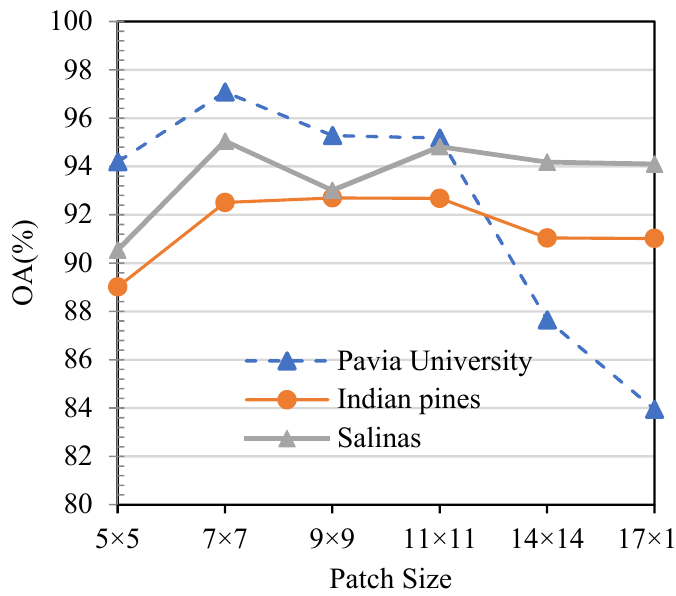
Figure 11. Parameter Sensitivity Analysis.